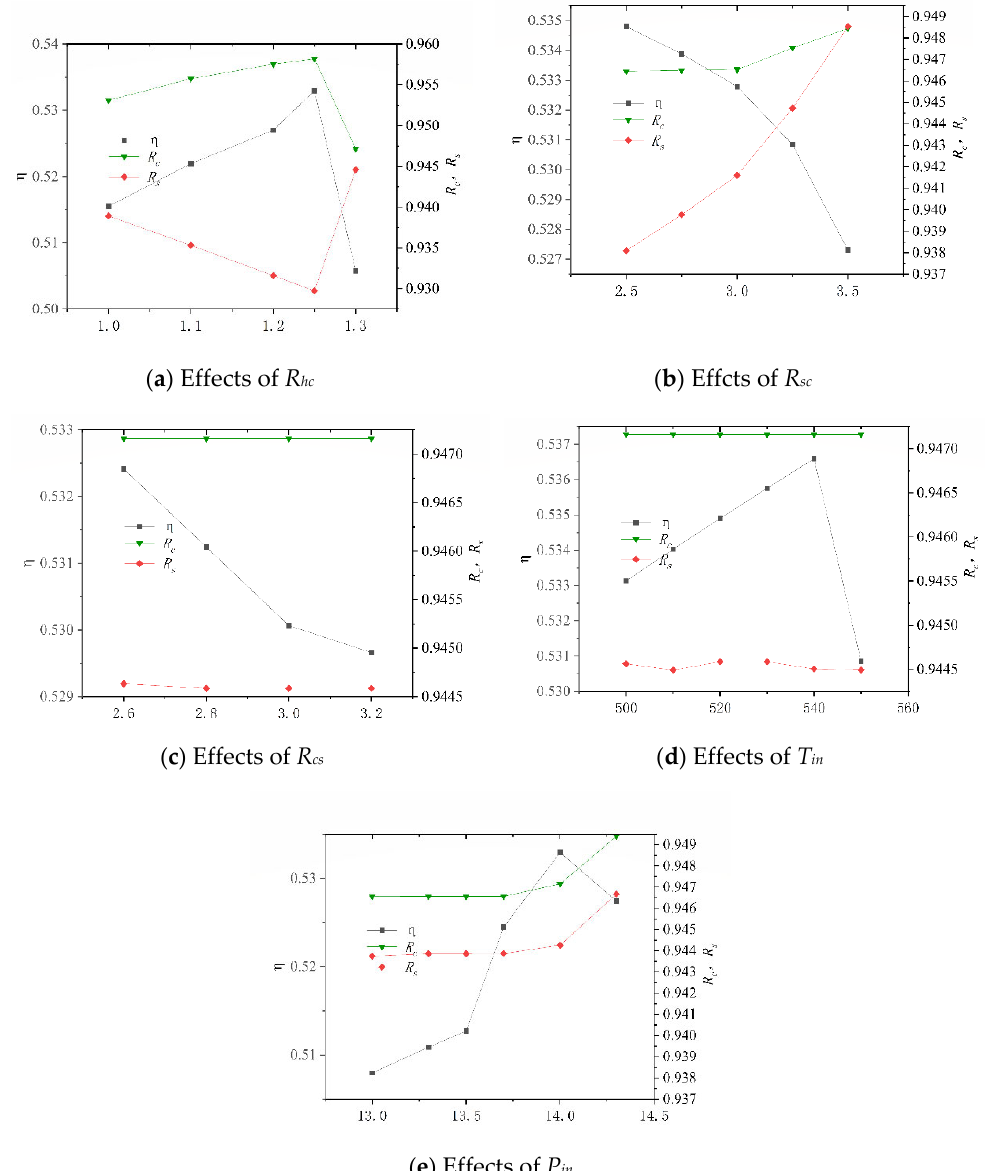
Figure 9. Effects of different working parameters on the system performance.